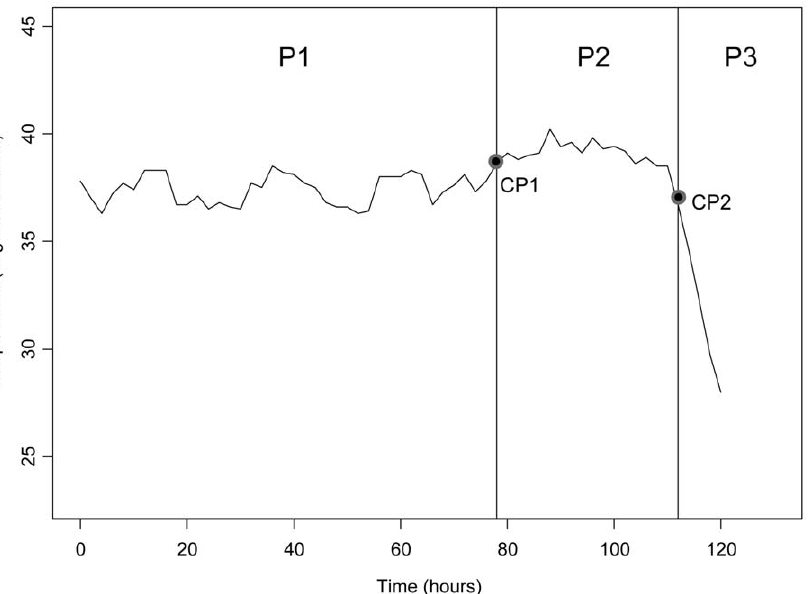
Figure 2. A representative mouse subcutaneous temperature curve in response to infection with F.tularensis type B is shown. P1, P2 and P3 represent phase 1 (normal phase), phase 2 (febrile phase) and phase 3 (hypothermic phase), respectively. Black dots on the temperature curve labeled CP1 and CP2 represent change point 1 and change point 2, respectively.